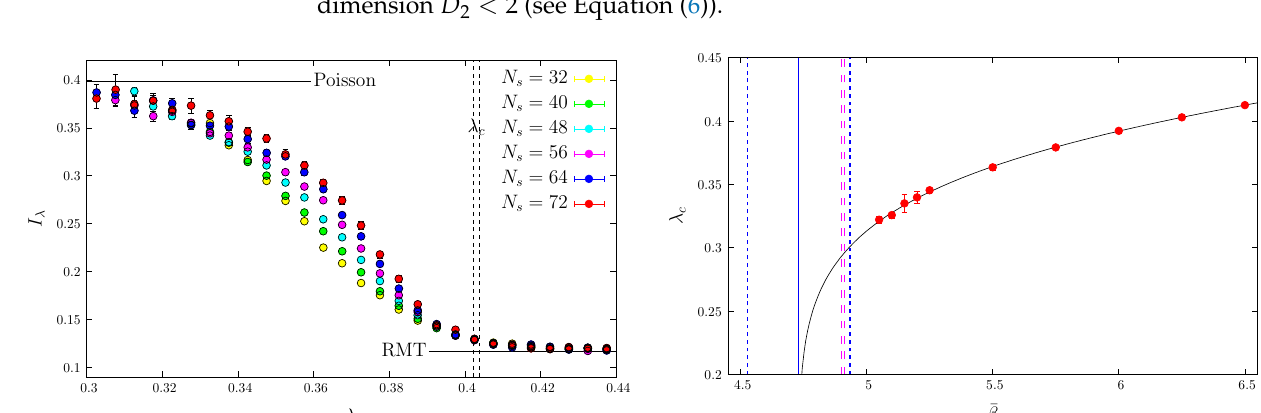
Figure 16. Spectral statistics I s along the spectrum for various volumes at coupling ¯ β = 6.25 ( left ), and mobility edge as 0 a function of ¯ β ( right ) for the staggered operator in 2+1-dimensional pure gauge SU(3) theory. (Here ¯ β = β /3 with β the Wilson action coupling.) In the left panel, Poisson and RMT predictions and the position of the mobility edge are also shown. In the right panel, a power-law fit (black solid line) to λ c , the position (blue solid line) and error band (blue dashed lines) of ¯ β ¯ β c (magenta dashed lines) are also shown. From loc at which λ c extrapolates to zero, and the error band of the critical Ref. [53]. (Figures adapted from M. Giordano, J. High Energy Phys. 05, 204 (2019), and used under a CC-BY 4.0 license